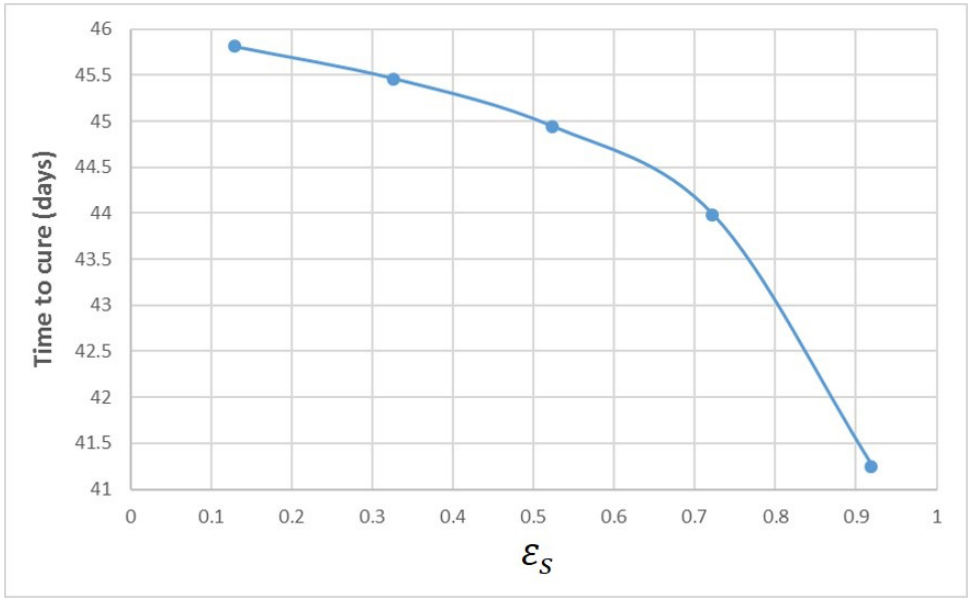
Figure A3. Influence of parameter (cid:101) s in the multiscale model on time-to-cure.